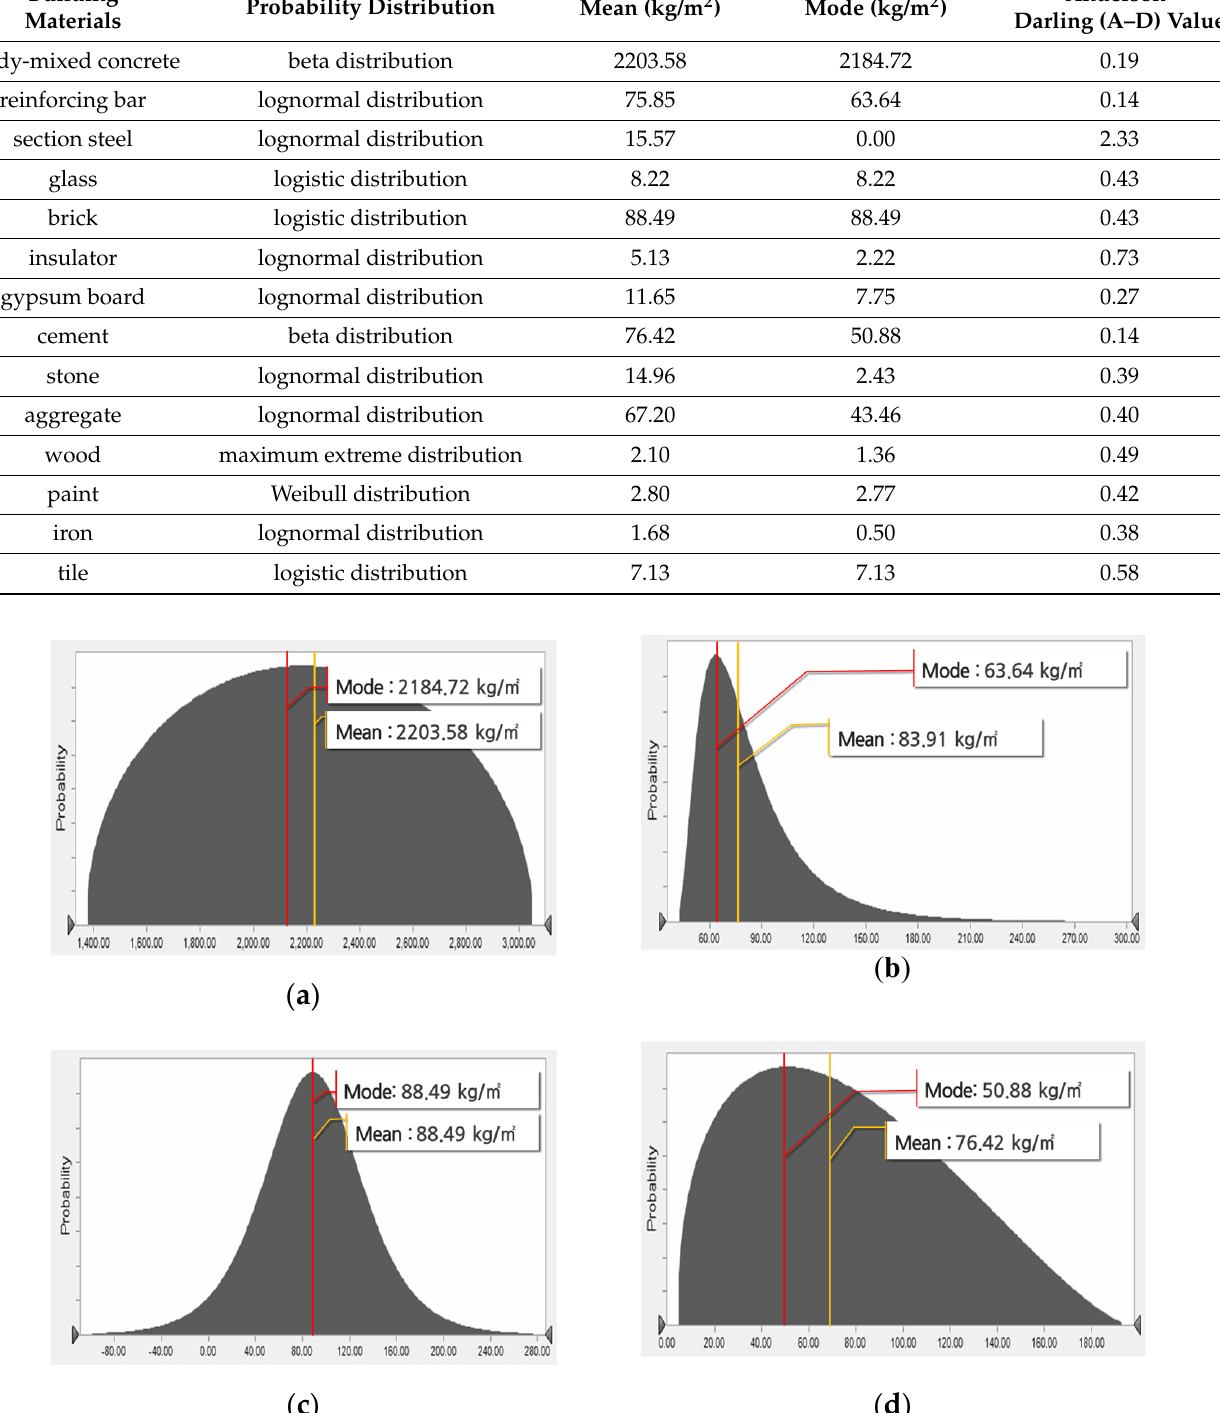
Figure 2. Probability distributions of representative building materials for apartment buildings. ( a )